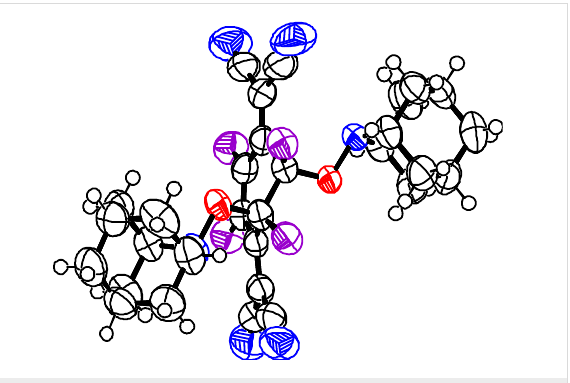
Figure 2: Molecular structure of the adduct 5 obtained by X-ray